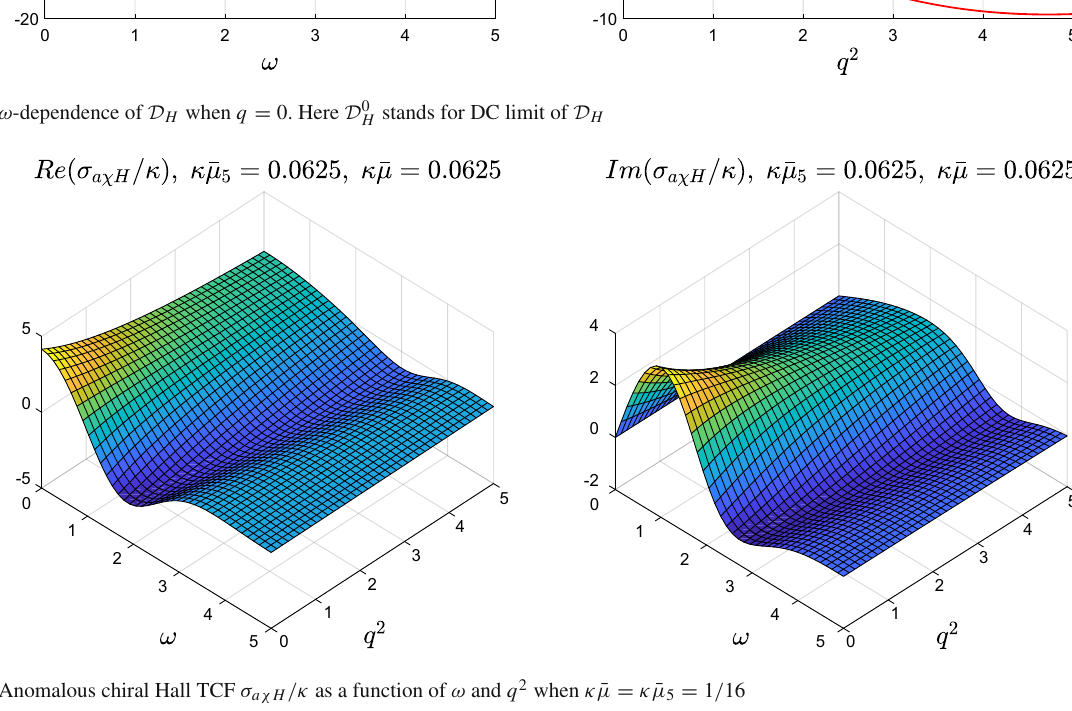
Fig. 7 Anomalous chiral Hall TCF σ a χ H /κ as a function of ω and q 2 when κ ¯ μ = κ ¯ μ 5 = 1 / 16